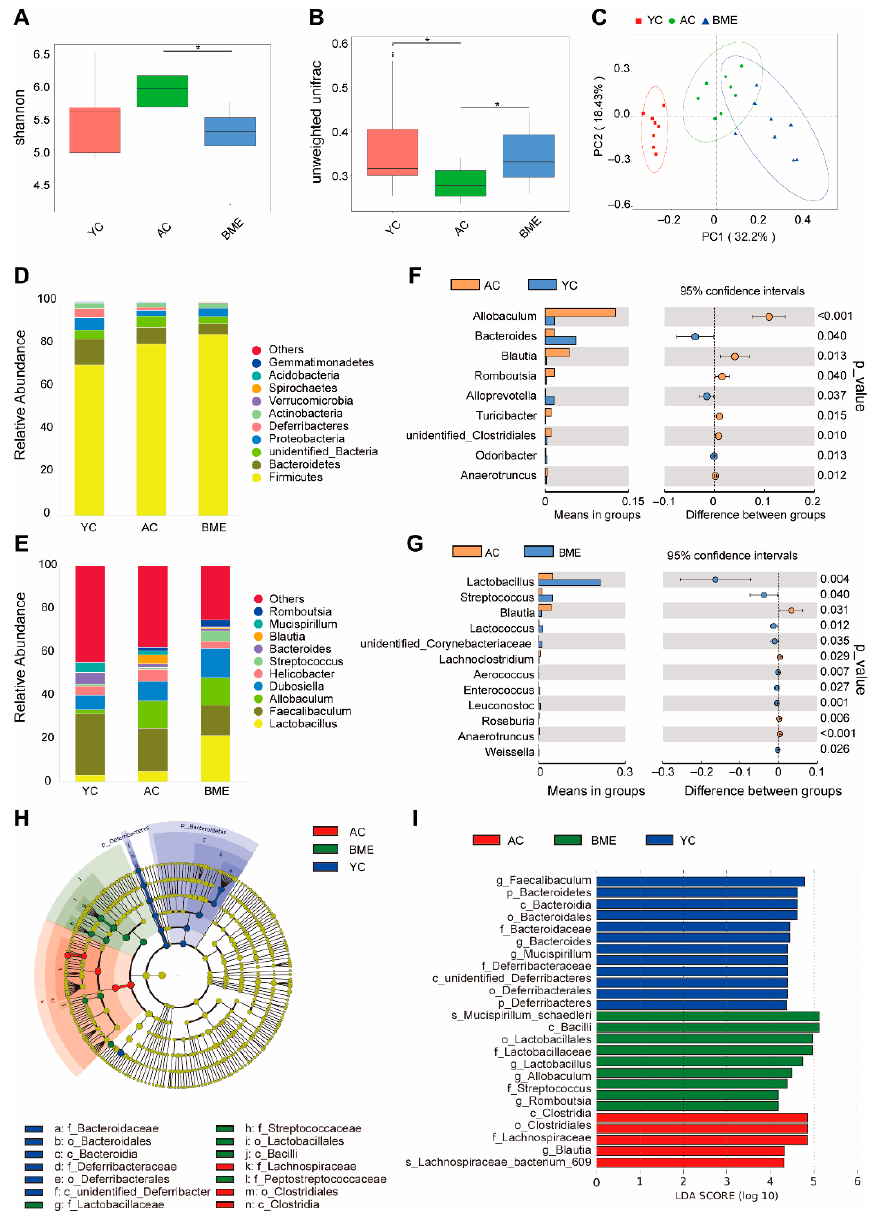
Figure 6. Effects of BME on the gut microbiota of mice were detected using a 16S rRNA sequencing- based analysis. ( A ) Alpha diversity of the microbial community in each group, analyzed by the Shannon index. ( B ) Intragroup beta diversity of the microbial community in each group, measured by unweighted UniFrac. ( C ) The principal components analysis based on Bray–Curtis metrics. ( D ) Relative abundances of predominant bacteria at the phylum level. ( E ) Relative abundances of top 10 bacteria at the genus level. ( F ) Differential microbiota analysis between the AC and YC groups. ( G ) Differential microbiota analysis between the AC and BME groups. ( H ) LEfSe analysis performed among the three groups. ( I ) Cardiogram showing differentially abundant taxonomic clades with LDA scores of 4.0 among groups with p values of 0.05. All results are expressed as means ± SEMs ( n = 8). * p < 0.05 between groups. YC: young control, AC: aged control, BME: blueberry–mulberry extracts, LDA: linear discriminant analysis, LEfSe: linear discriminant analysis effect size, YC: young control.